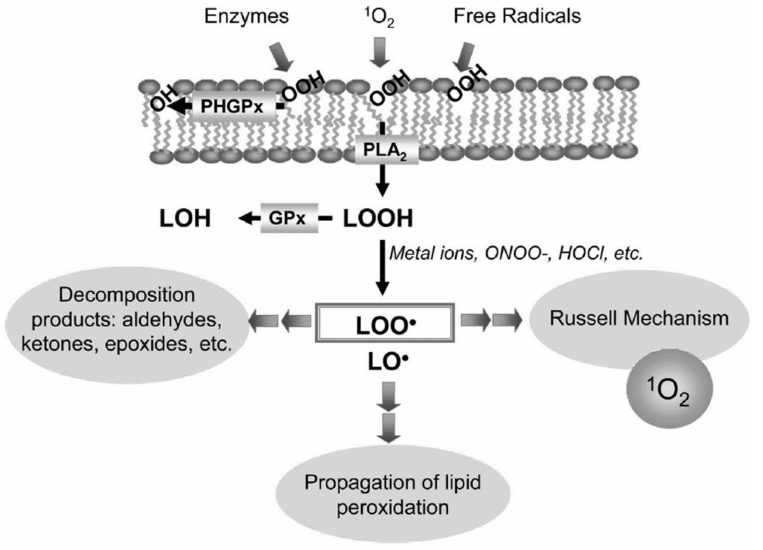
Figure 4. Generation and fate of lipid hydroperoxides in membranes. Adopted with permission from [9]. Copyright 2007, John Wiley &